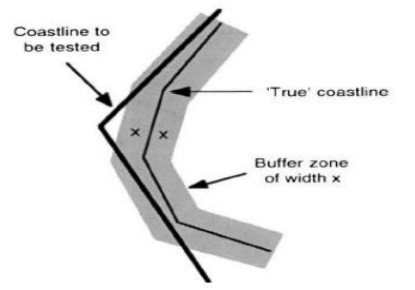
Figure 1 Goodchild & Hunter buffer comparison technique (source: Goodchild & Hunter